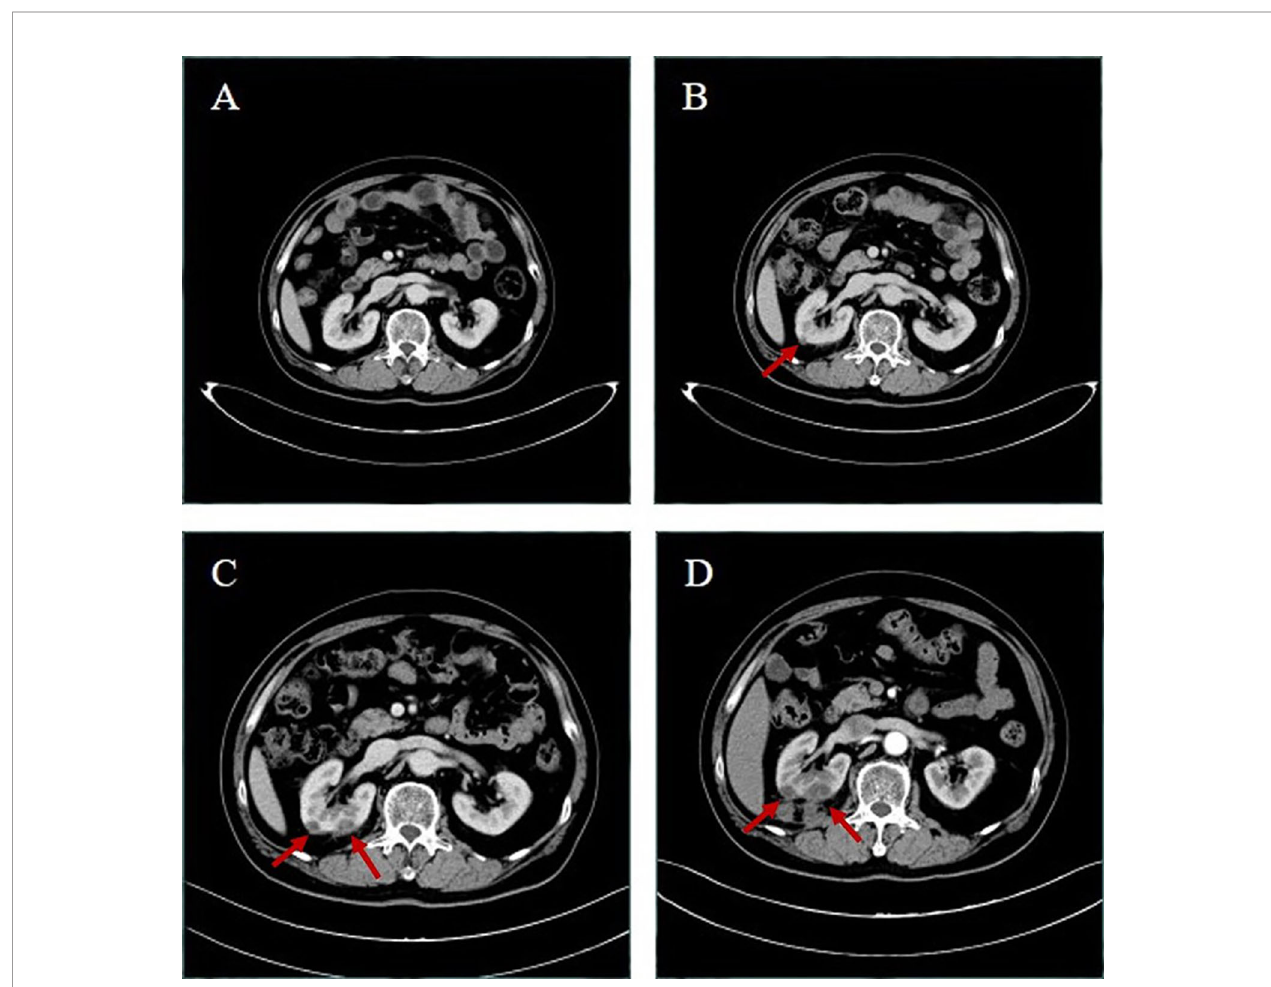
FIGURE 1 | Upper abdominal computed tomography (CT) of the patient. (A) After more than 3 months ’ therapy with crizotinib in May 1, 2020, both kidneys have uniform density and no abnormity. (B) After 5 months ’ therapy in June 27, 2020, the right kidney appeared to have new slightly low-density lesions; the larger one was about 10 mm in diameter. (C) After more than 6 months ’ therapy in August 20, 2020, the right kidney appeared to have slightly low-density lesions larger than in June 27, 2020, and the larger one was about 13 mm in diameter, and the right kidney appeared to have a new low-density lesion, whose diameter was about 18 mm. Upper abdominal enhanced CT in October 2, 2020 (D) showed that multiple low-density lesions in and around the right kidney were enlarged and partially new; the larger one was about 24 mm in